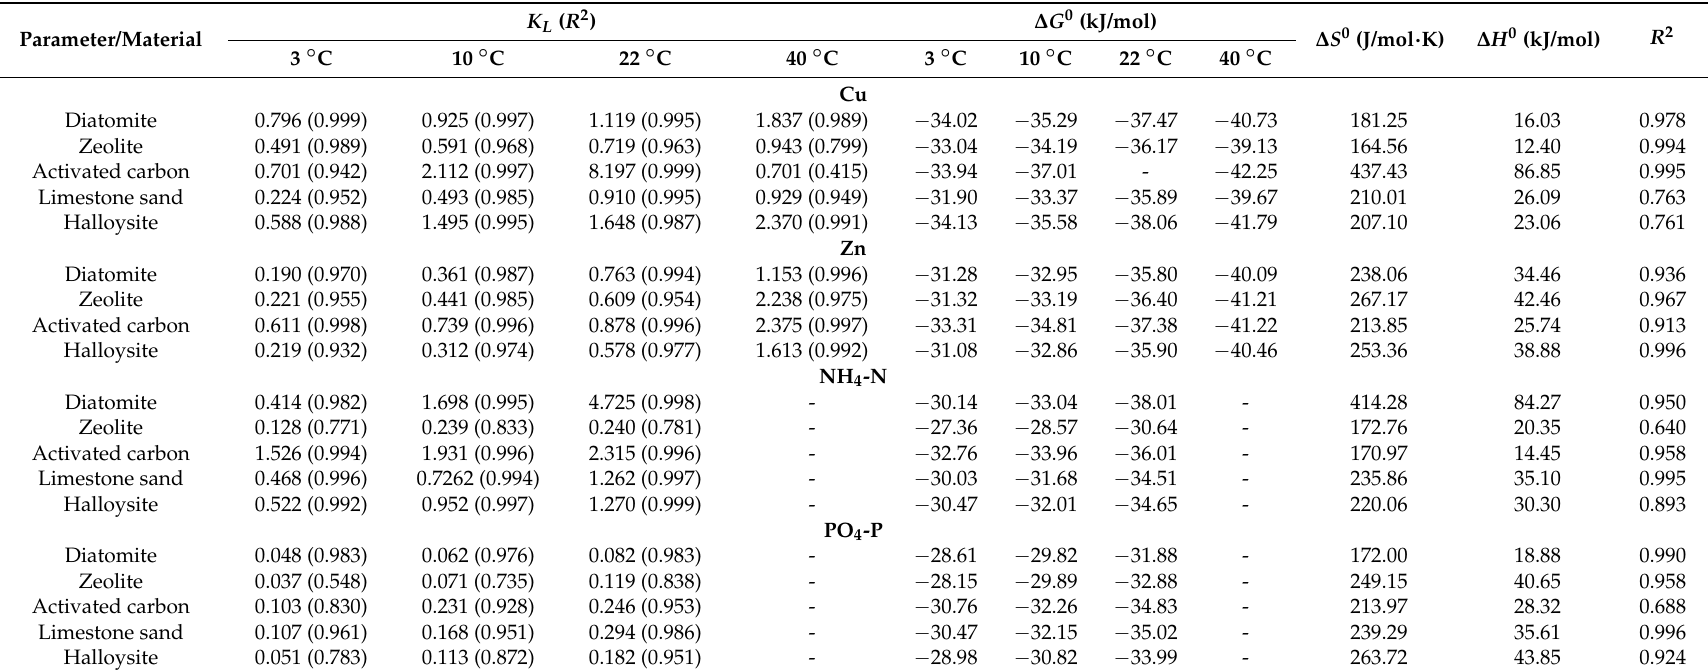
Table 4. Constants of the Langmuir equilibrium constant K L and thermodynamic